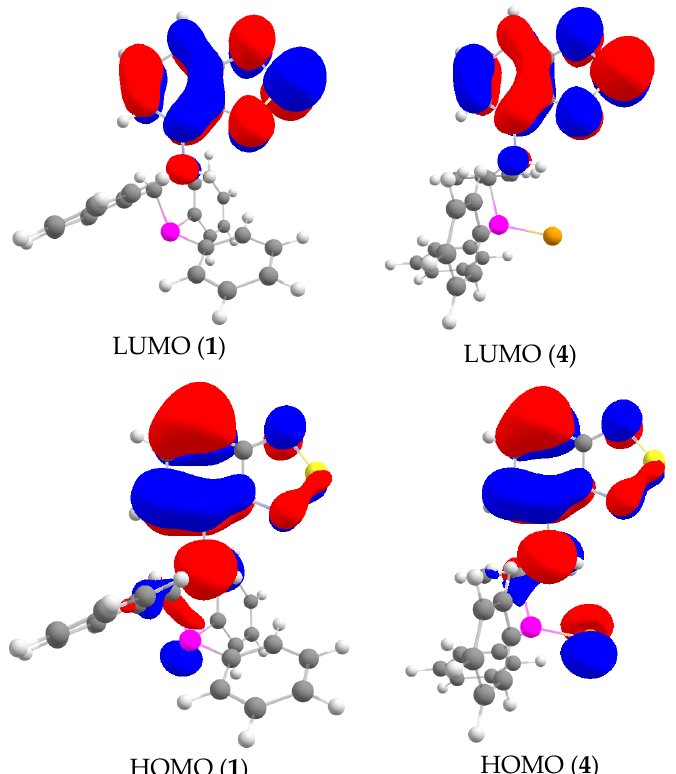
Figure 5. Frontier orbitals of 1 and 2 – 4 on the example of 4 in the equilibrium geometries of the